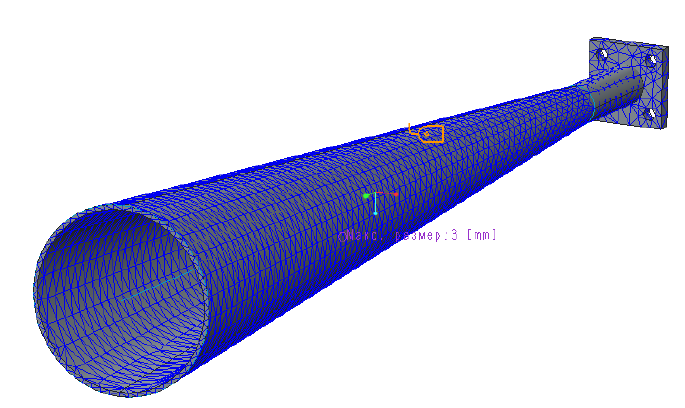
Fig. 4. Polygonal models of a conical horn